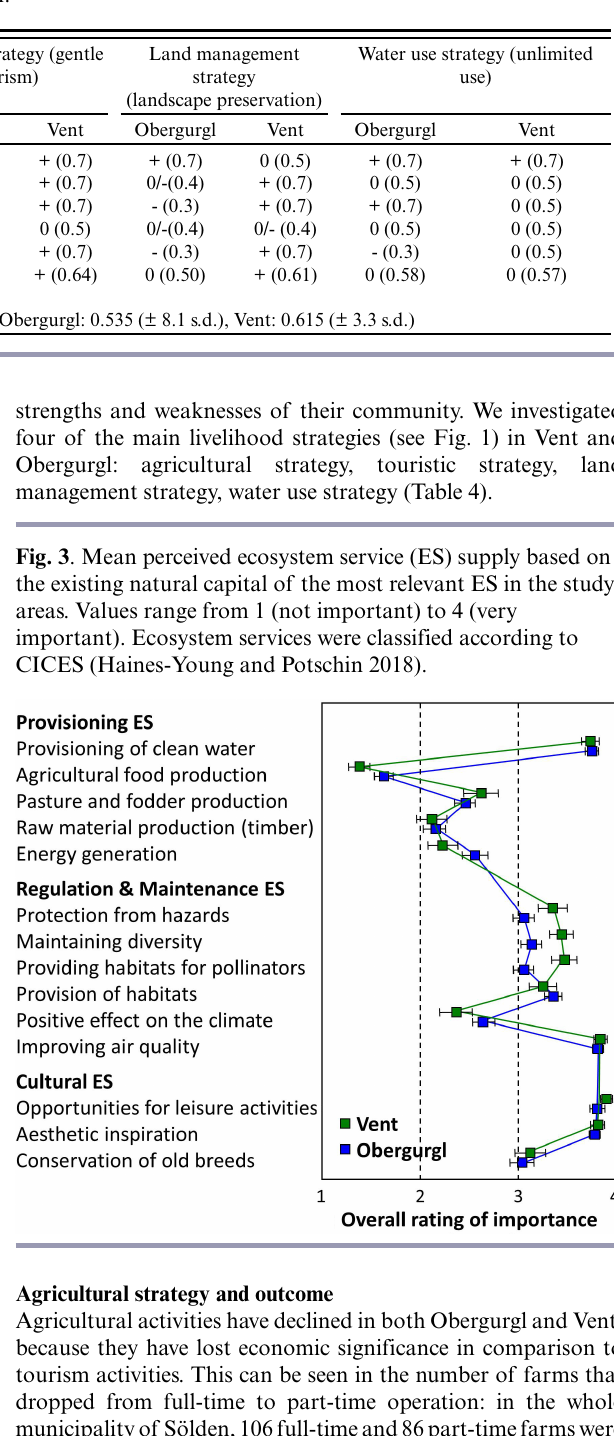
Table 3 . An illustrative summary of the effects of the livelihood strategies on the mean class status of the capitals as the basis for the evaluation of resilience for Obergurgl and Vent. Key: ++ (0.9) highly positive, + (0.7) positive, o (0.5) neutral, - (0.3) negative, and - - (0.1) highly negative impact of the strategy on the respective capital.